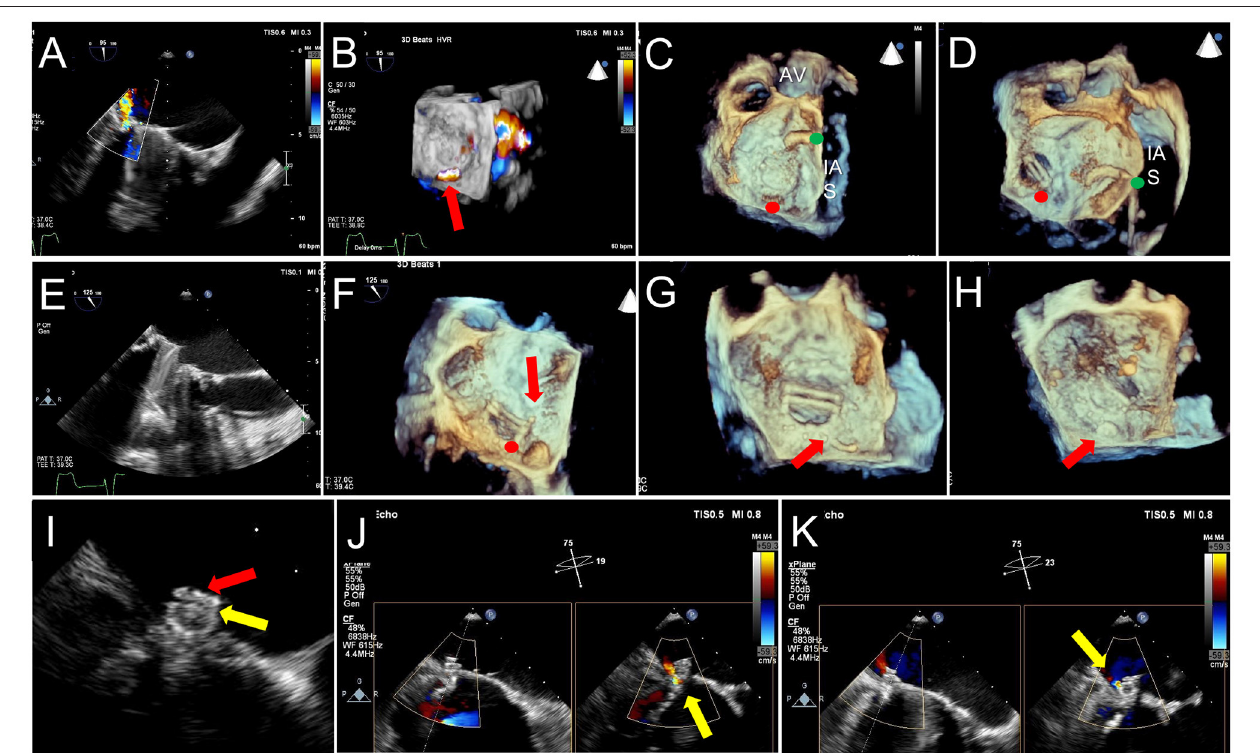
FIGURE 11 | TEE Guidance of Challenging Closure of Posteromedial PVL. A posterior paravalvular leak resulting in hemolysis is visualized by 2D color Doppler (A) and 3D color Doppler Imaging (between 5 and 6 o clock in a surgeon’s view, red arrow, B) . (C) The first attempt at transseptal puncture is shown (green circle). The location of PVL is marked by a red circle. (D) After unsuccessful attempts to cross the defect, the septum was repunctured more posterior (green circle) for a better trajectory toward the defect. (E) After additional unsuccessful attempts, the approach was changed to retrograde. (F) As acoustic shadowing limits visualization on the ventricular aspect of the mechanical mitral prosthesis, wire exit point was visualized in the left atrium. Here, the wire is visualized inside the sewing ring (red arrow) adjacent to the PVL (red circle). (G) After reorientation of the wire, the defect was successfully crossed (red arrow). (H) The atrial disk of an AVPII closure device is visualized after deployment on 3D imaging (red arrow). (I) 2D echocardiography demonstrates the atrial disk (red arrow) and a portion of the center cylinder (yellow arrow). (J) A residual peri-device jet is seen (yellow arrow). (K) After device re-sheathing and slight repositioning, there is a trivial residual PVL jet flowing through the center of the closure device (yellow arrow). AV, aortic valve; IAS, interatrial septum.